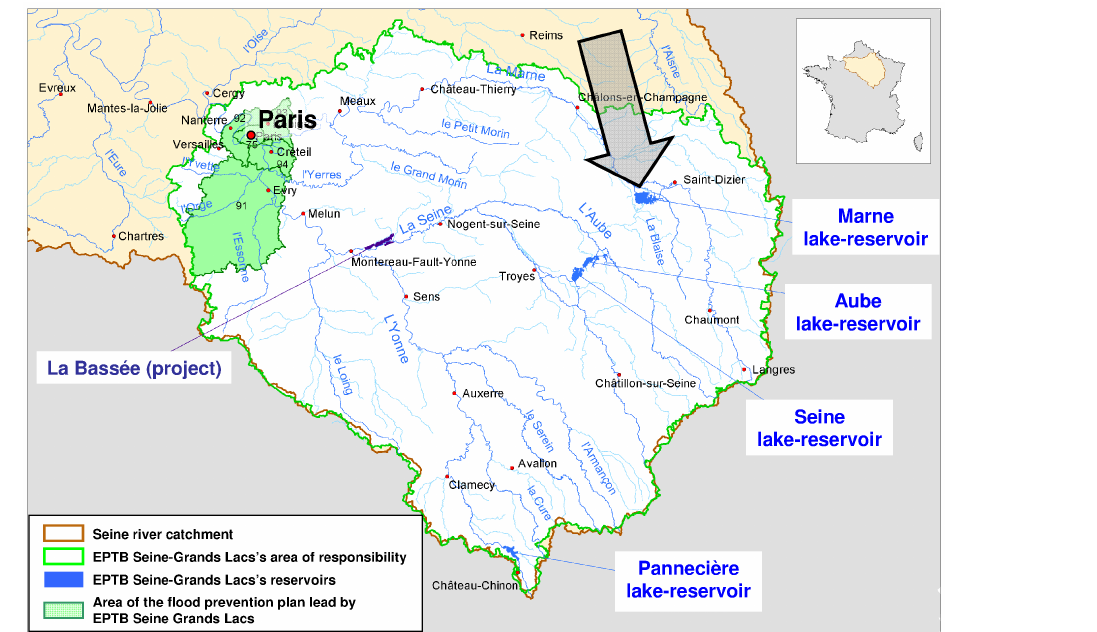
Figure 1. Area managed by EPTB Seine-Grands Lacs and location of the Marne lake-reservoir (grey arrow). Source: EPTB Seine-Grands Lacs.